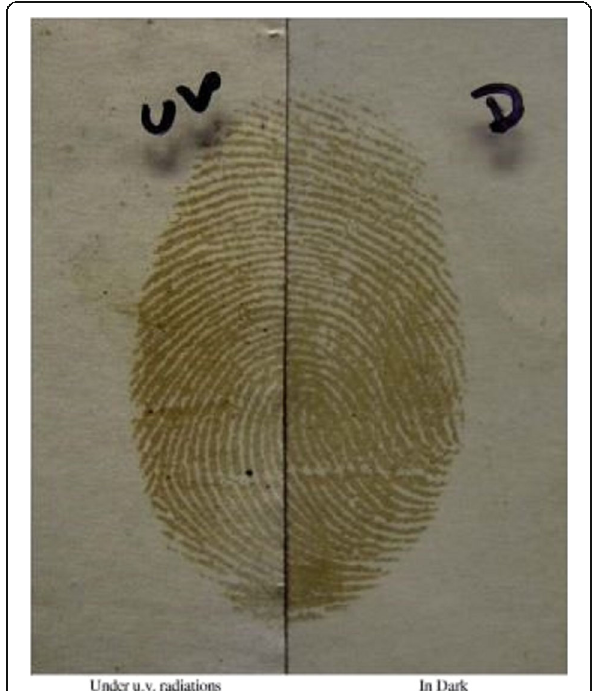
Fig. 5 Example of fingerprints on thermal paper developed using iodine fuming observed under UV light (left panel), and in dark (right